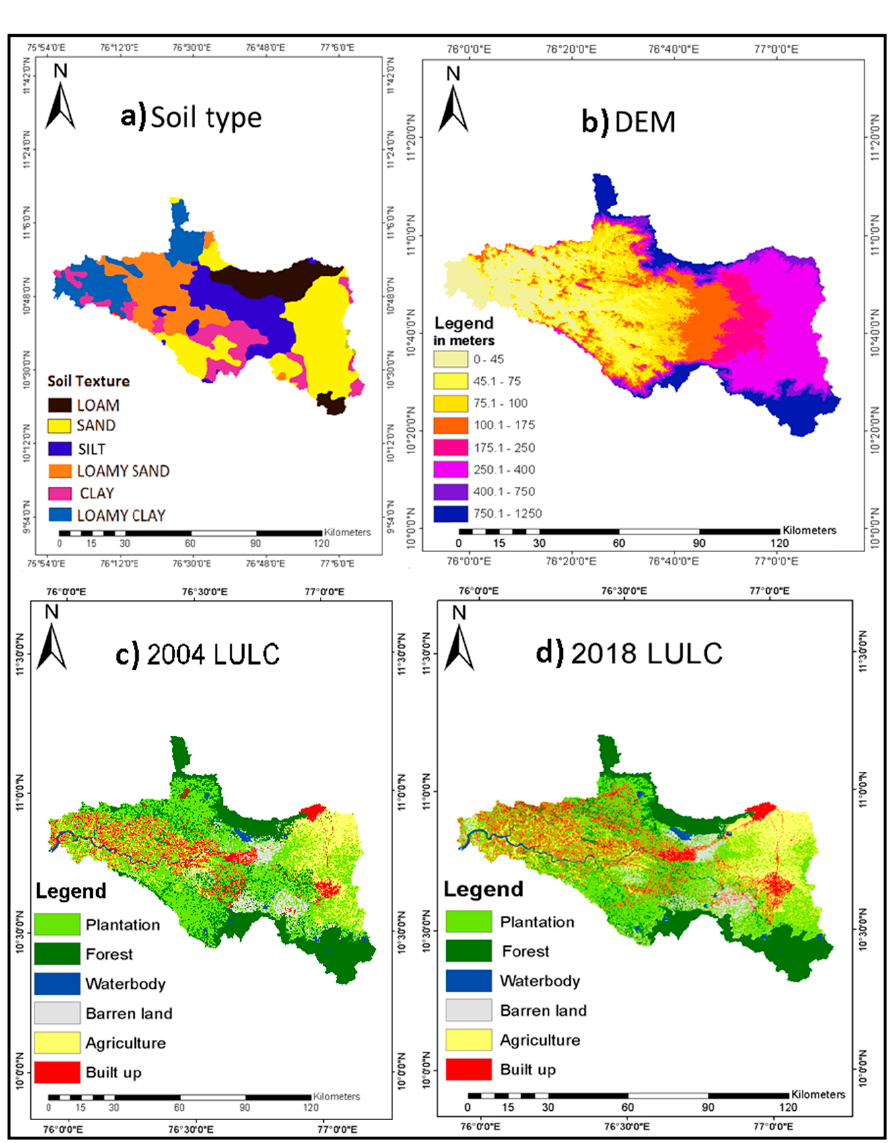
Figure 2. Map showing the geophysical details of the BRB ( a ) soil map, ( b ) digital elevation model (DEM), and ( c , d ) 2004 and 2018 LULC classified